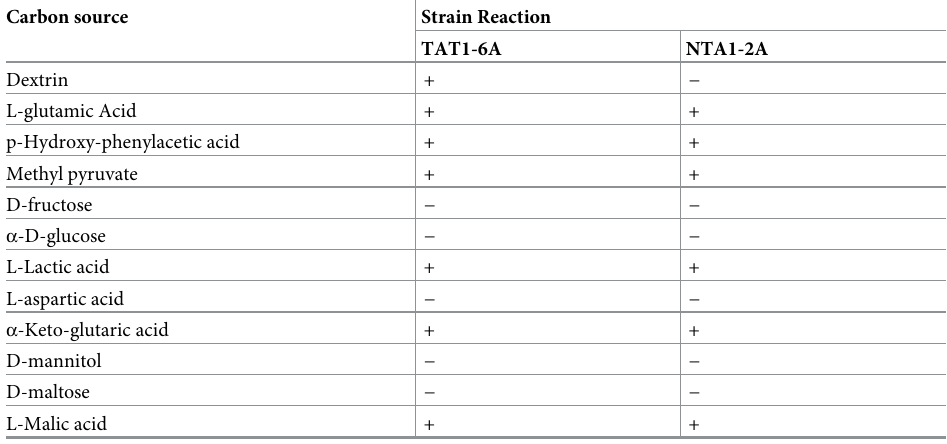
Table 1. Biochemical and physiological characteristics of NTA1-2A and TAT1-6A strains using the GEN III MicroPlate identification tool. Carbon